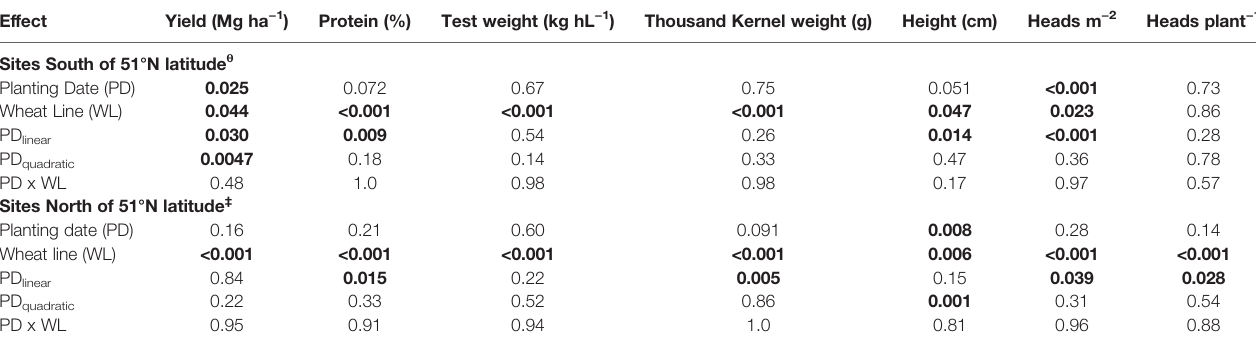
TABLE 4 | Probability values from the analysis of variance for each dataset for the fi xed effects of planting date and wheat line. Environments, replicates within each environment, and interactions between random and fi xed effects are considered to be random.